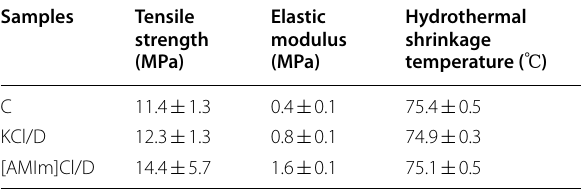
(Fig. 3; Additional file 1: Fig. S2D). For this reason, the